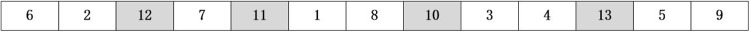
A random chromosome.